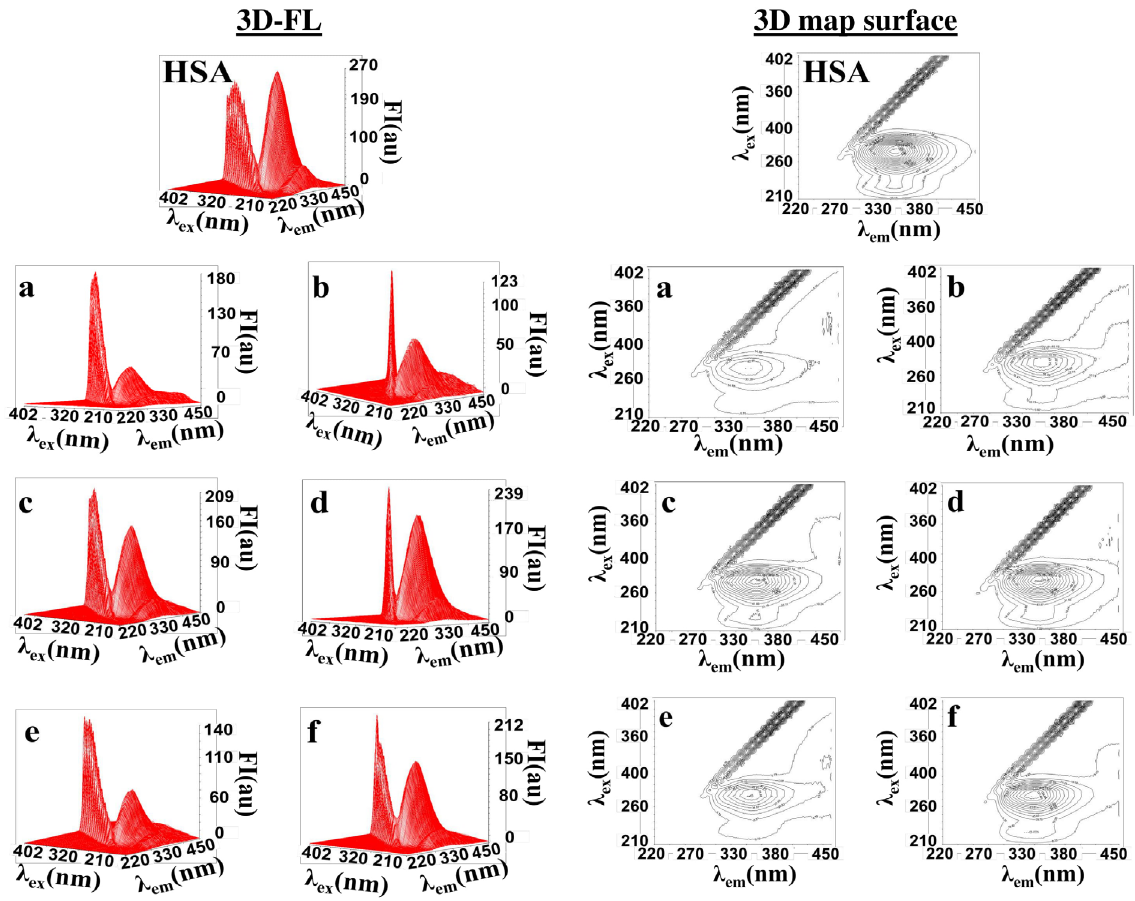
Figure 4. The three-dimensional fluorescence (3D-FL) and 3D map surface spectra of HSA and HSA + flavonoid systems. 5 µg/mL HF1 + HSA (a), 1.7 μg/mL HF2 + HSA ( b ), 5 μg/mL HF3 + HSA ( c ), 5 μg/mL HF4 + HSA ( d ) 5